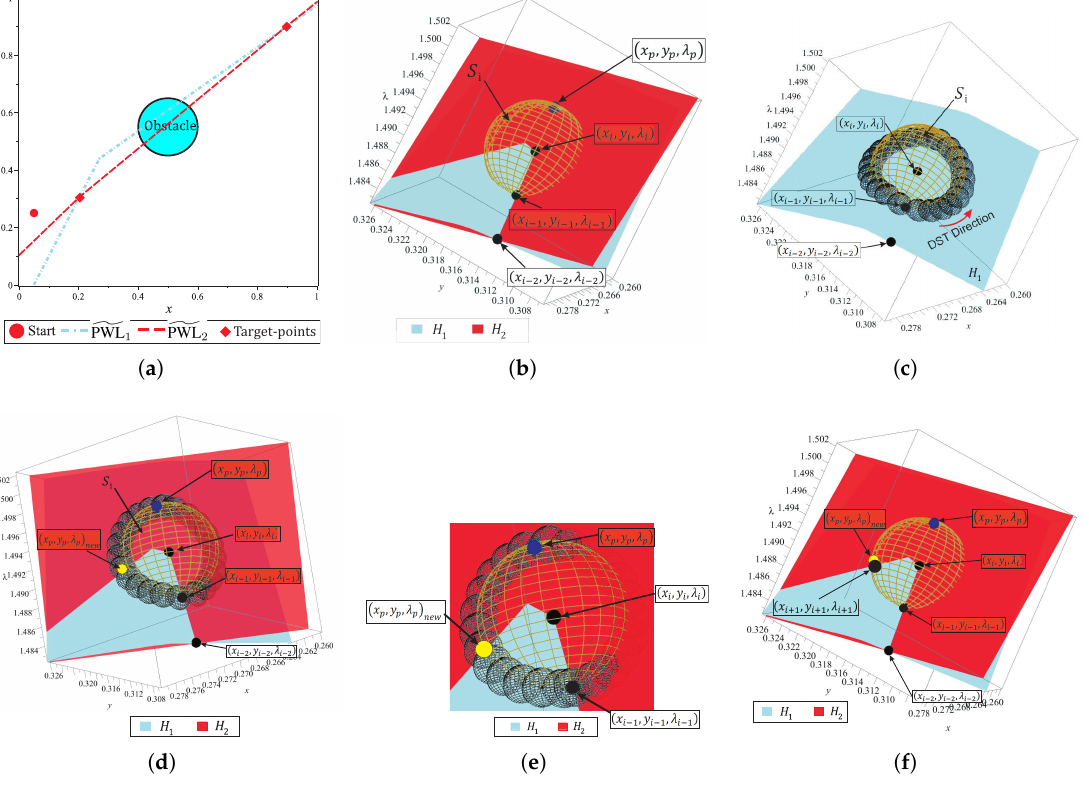
Figure 10. Double spherical tracking strategy. ( a ) Environment map with two target-points. ( b ) Non-convergence issue. ( c ) Double spherical tracking H 1 and S i . ( d ) Double spherical tracking. ( e ) Double spherical tracking (zoom view). ( f ) New